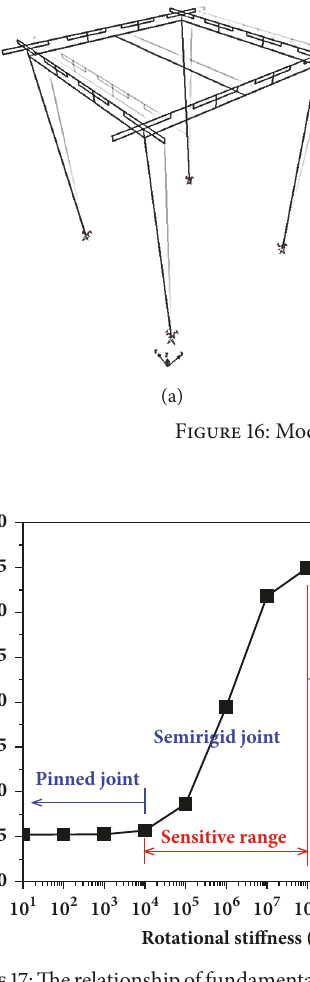
Figure17:Therelationshipoffundamentalfrequencyandrotational stiffness of